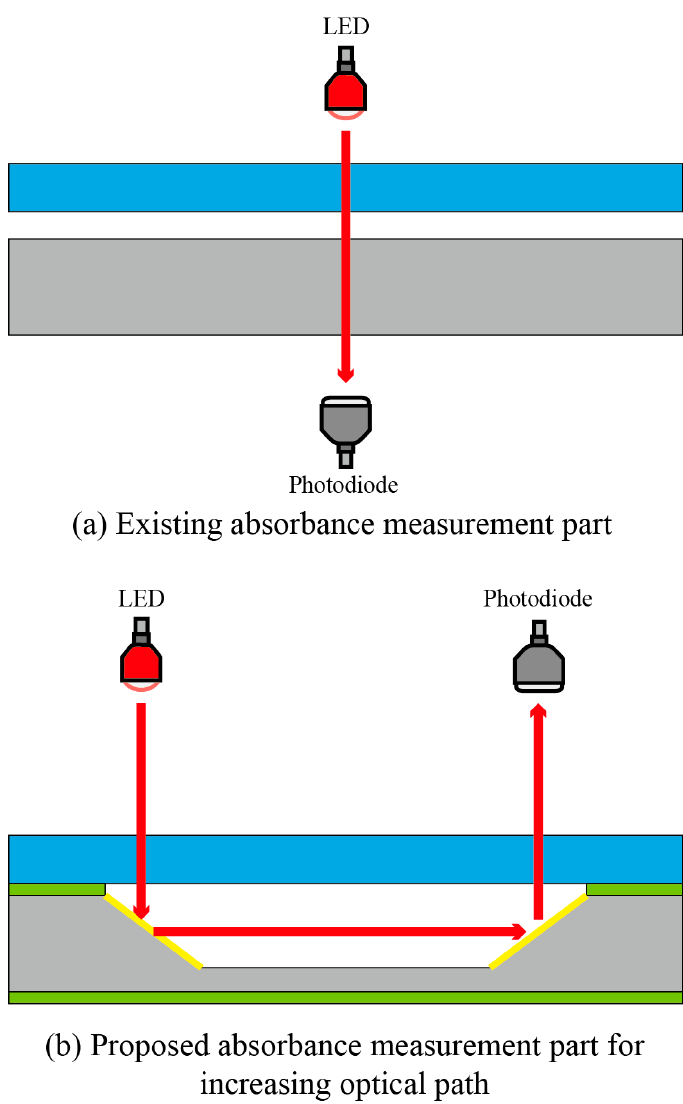
Figure 4. ( a ) The existing absorbance measurement part with ( b ) the proposed absorbance measurement